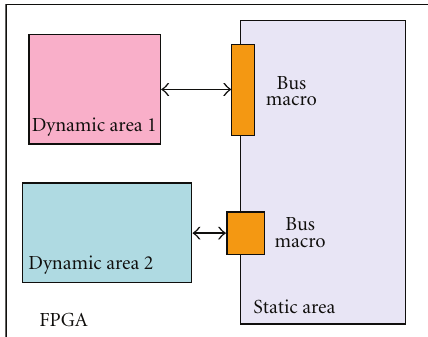
Figure 6: Architecture of a basic run-time reconfigurable system.